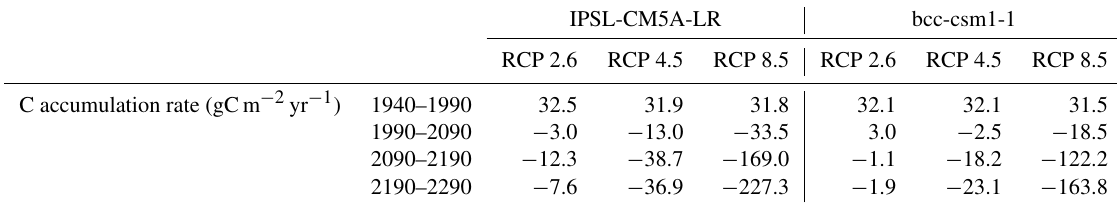
C accumulation rate is averaged from all grid cells weighted by the spatially explicit peatland